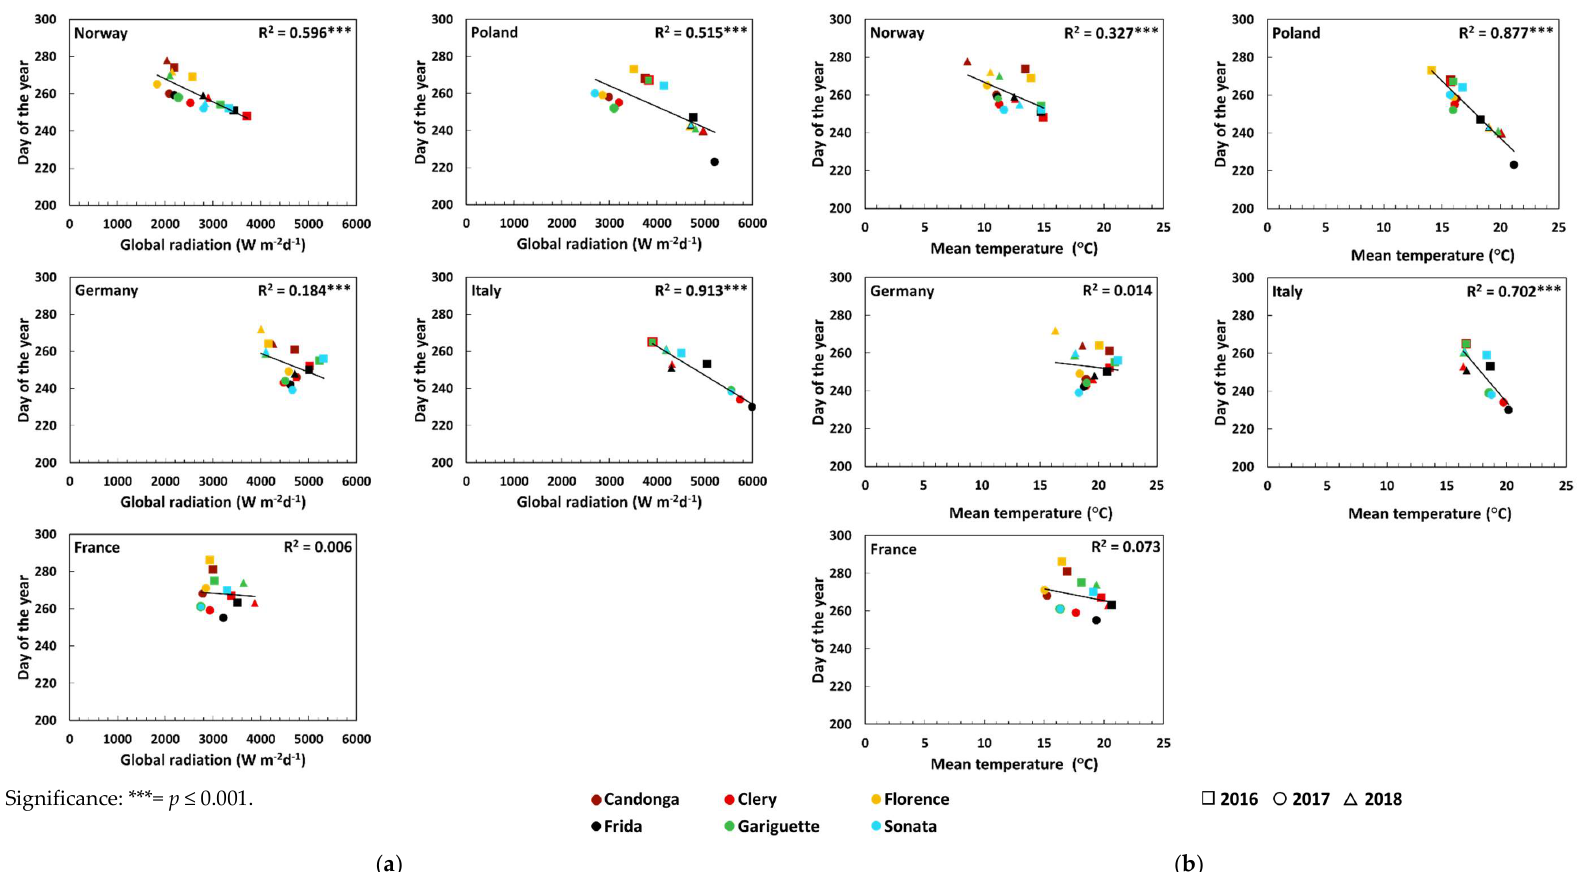
Figure A2. Day of the year for strawberry flower initiation (floral developmental Stage 2) for six strawberry cultivars grown at five locations in Europe as influenced by ( a ) global radiation and ( b ) mean temperature during the 3-week period preceding flower initiation for 3 years.